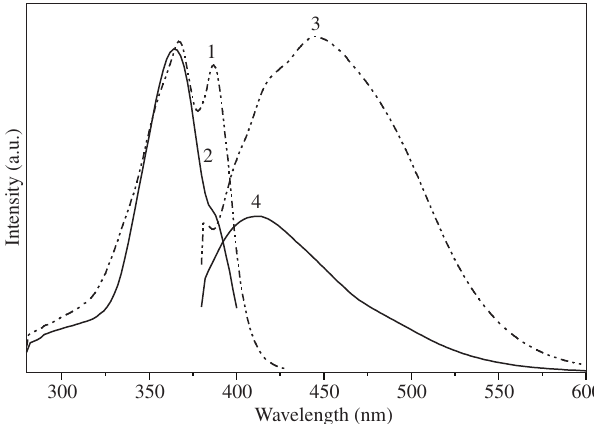
Figure 11. Excitation and fluorescence spectra of the DGEBA/DDS/9-AA mixture: excitation monitored at 1) 445 nm and 2) 415 nm, fluorescence ex- cited at 3) and 4) 365 nm. Dashed lines refer to DGEBA/DDM/9AA mixture before heat-treating; full lines refer to the DGEBA/DDM/9AA mixture after heat-treating at 120 °C for 2 h (5 °C/min heating